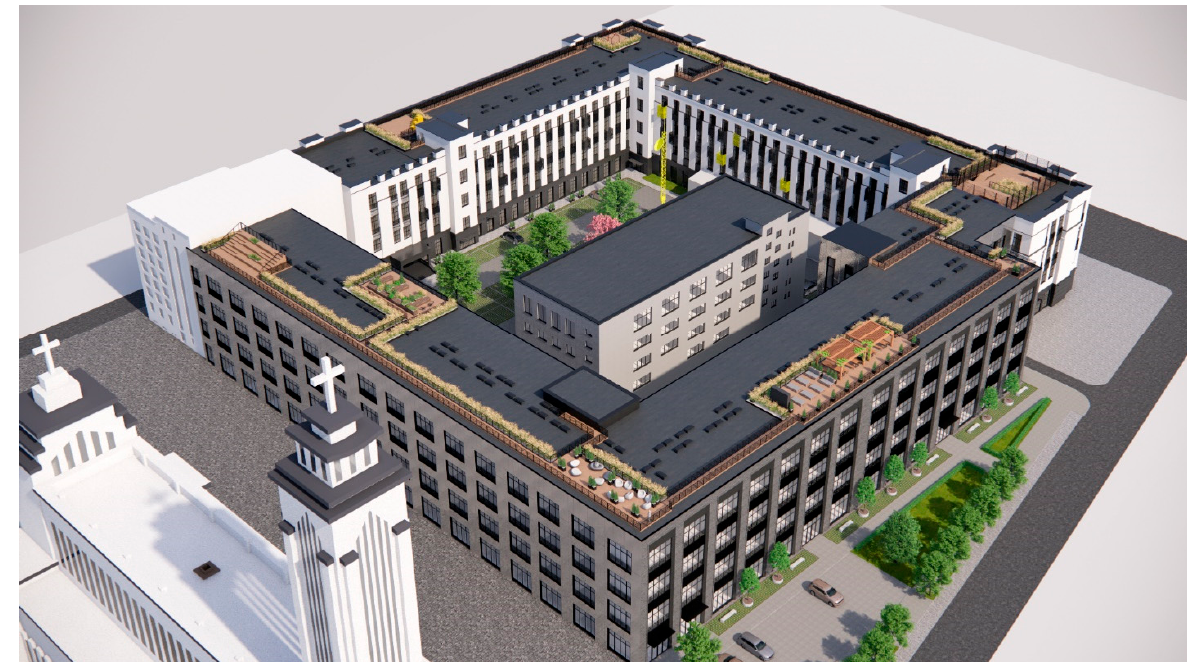
Figure 19. “Radio City” conversion project by Citus, 2020 (visualization courtesy of UAB Citus).